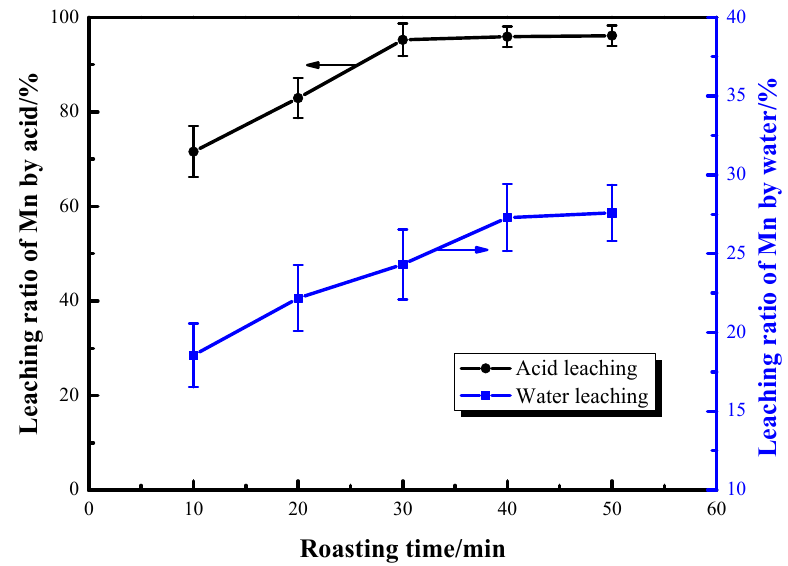
Figure 12. Effect of roasting time on the leaching ratio of Mn (450 °C, S 2 /MnO 2 : 0.5).